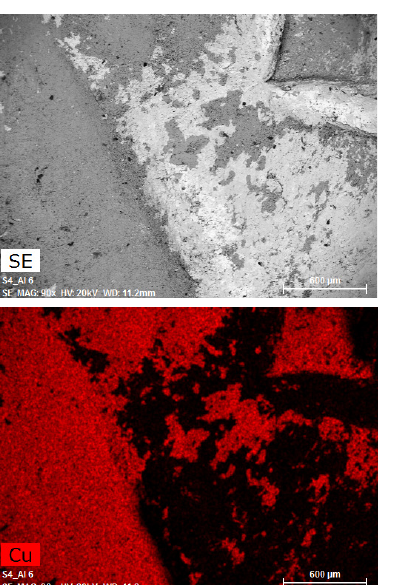
Figure 3. SE image and X-ray maps on the surface of antoninianus no. A48 obtained by SEM-EDX.